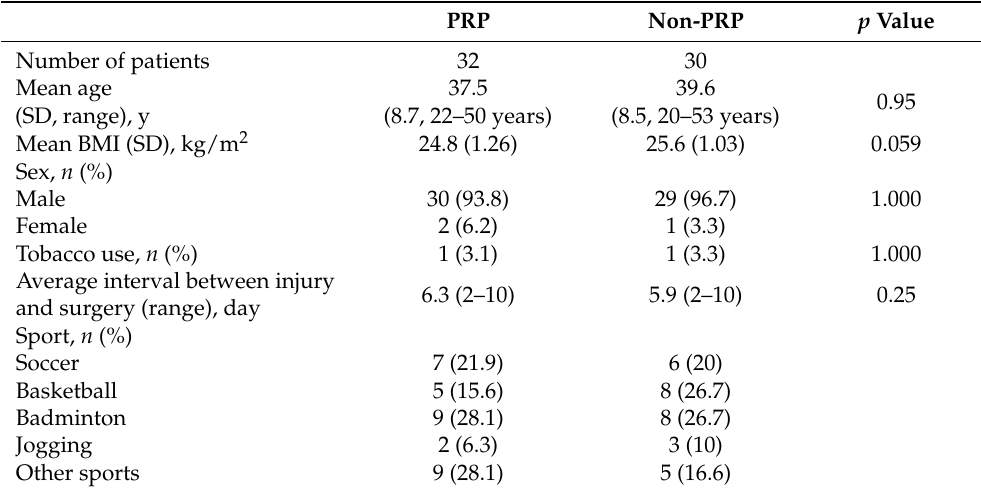
Table 1. Demographic data of patients with acute Achilles tendon rupture.